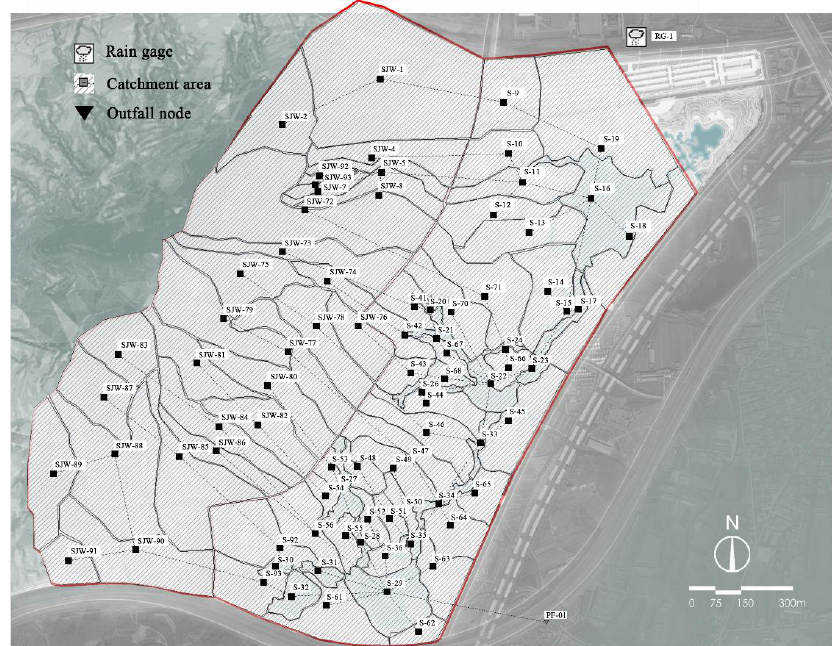
Figure 4. An SWMM overview map of the study area.